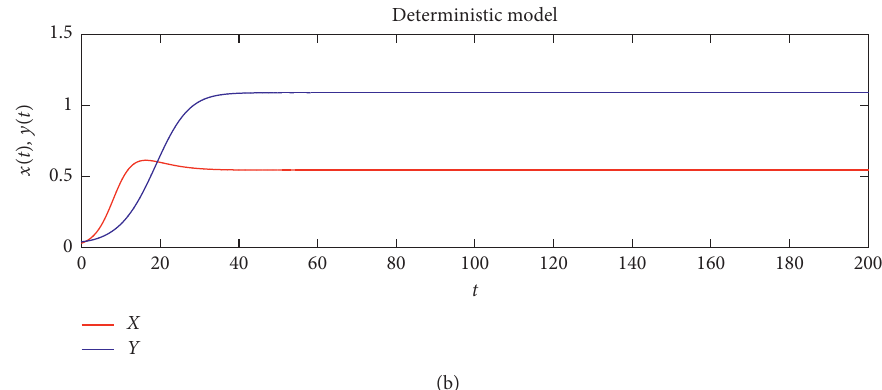
Figure 5: Computer simulations of the paths x ( t ) and y ( t ) for system (8) with the initial value ( x ( 0 ) , y ( 0 )) � ( 0 . 03 , 0 . 04 ) and σ � 0 . 8, and its corresponding deterministic model with initial value ( x ( 0 ) , y ( 0 )) � ( 0 . 03 , 0 . 04 ) σ 2